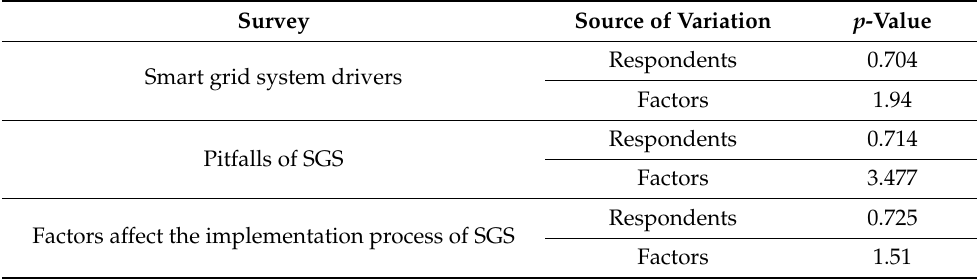
Table 4. The range of p -value through the correspondents and various factors.